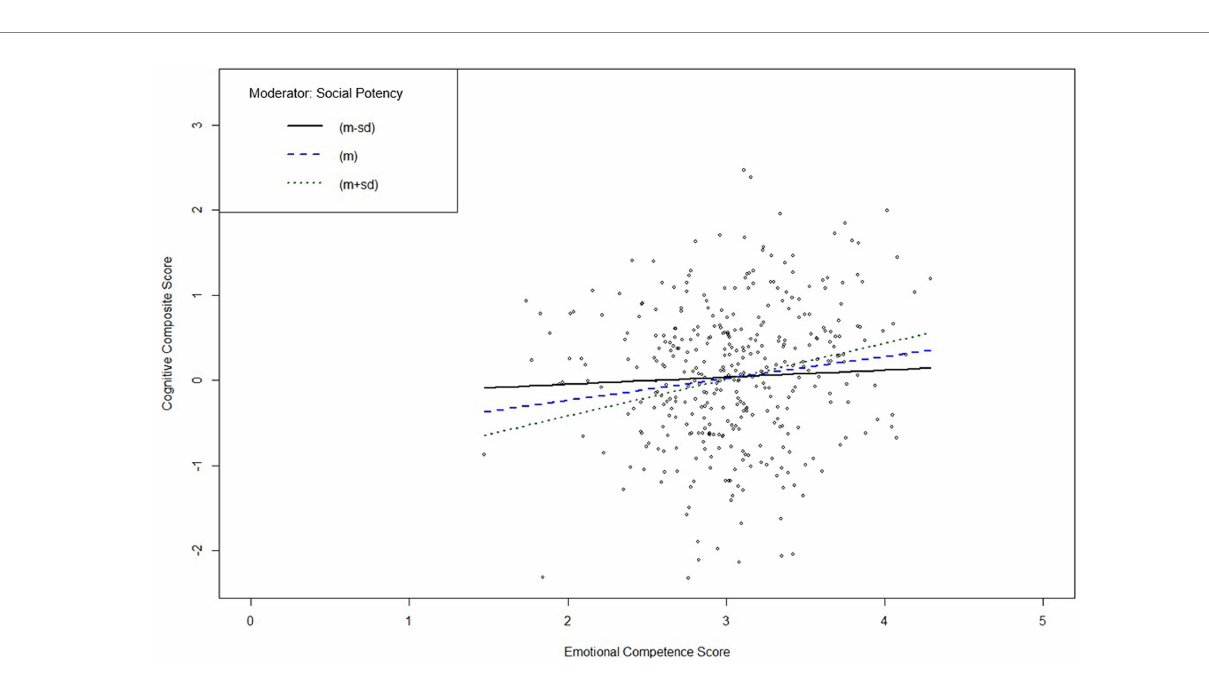
FIGURE 2 Interaction plot of the simple slope analysis of psychopathic personality trait “Social Potency” in individuals with depression. m , mean; sd , standard deviation. Simple slope analysis of the moderating effect of “Social Potency” on the relationship between the Emotional Competence Score and the Cognitive Composite Score indicates a significant moderation effect at high (+1 sd above m ; solid black line) and low ( − 1 sd below m ; dotted black line) values of “Social Potency” ( m is represented by the blue dashed line). Subsequent significance tests indicate a significant positive moderating effect for individuals with depression and high values in “Social Potency,” but not for individuals with depression and low values in “Social